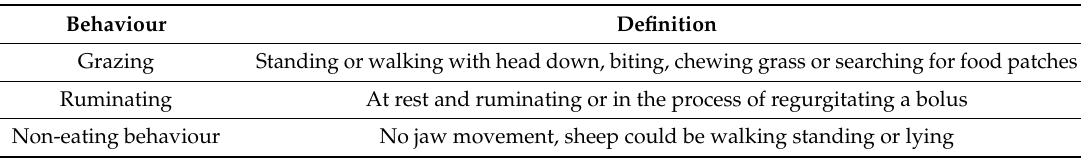
Table 1. Ethogram defining eating behaviours used for manual classification of behaviours from video